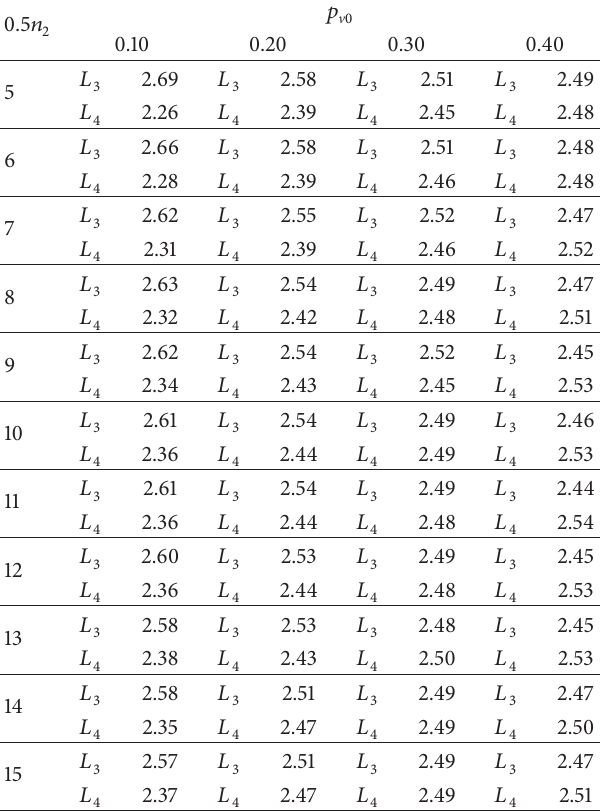
Table 6: The 𝐿 3 and 𝐿 4 with ARL V 0 ≈ 370 for various 0.5𝑛 2 and 𝑝 V 0 given 𝜆 2 = 0.05 .